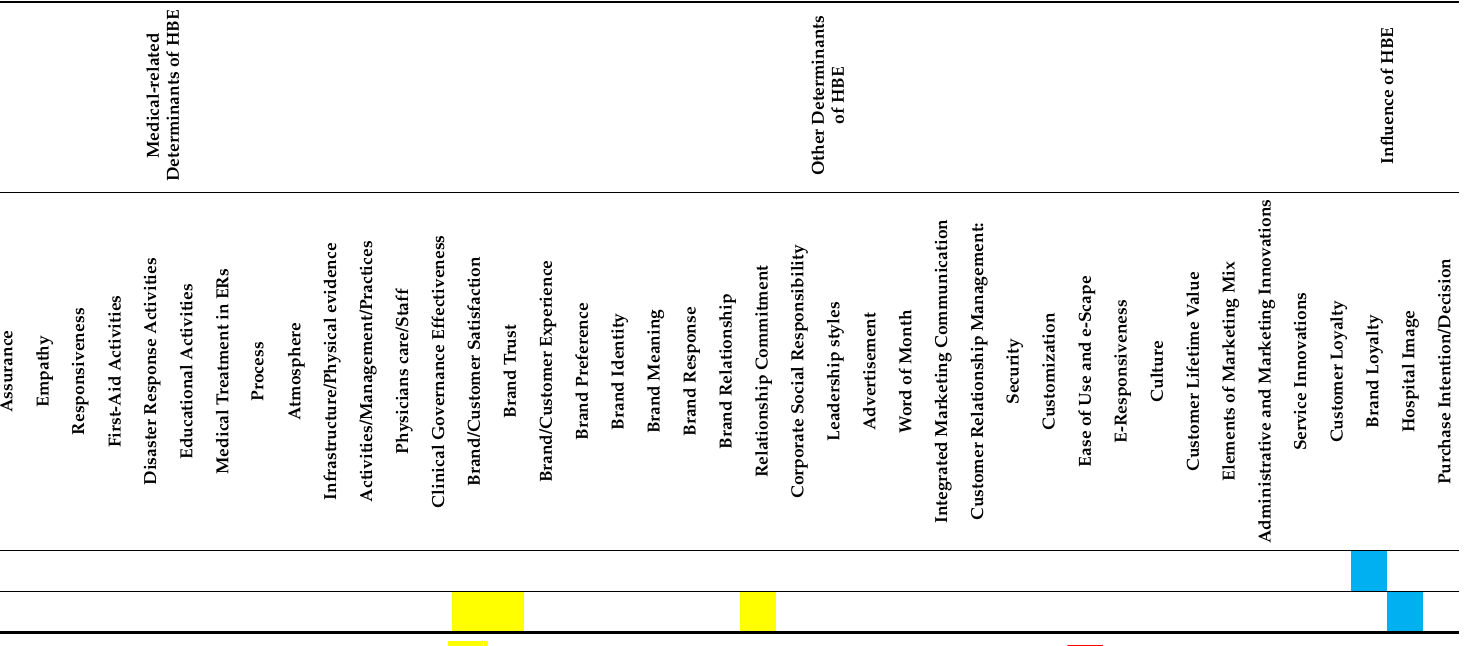
Factor having a direct effect on HBE (statistically significant). Factor having an indirect effect on HBE (statistically significant). Factor studied but not influenced either directly or indirectly by HBE. HBE as a factor affecting other factors.